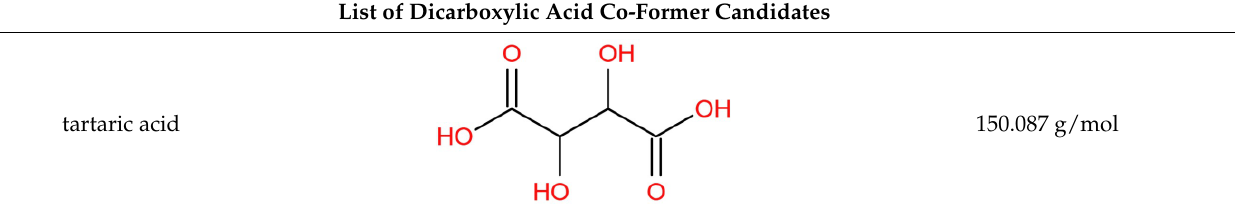
Table 1. Cont. List of Dicarboxylic Acid Co-Former Candidates